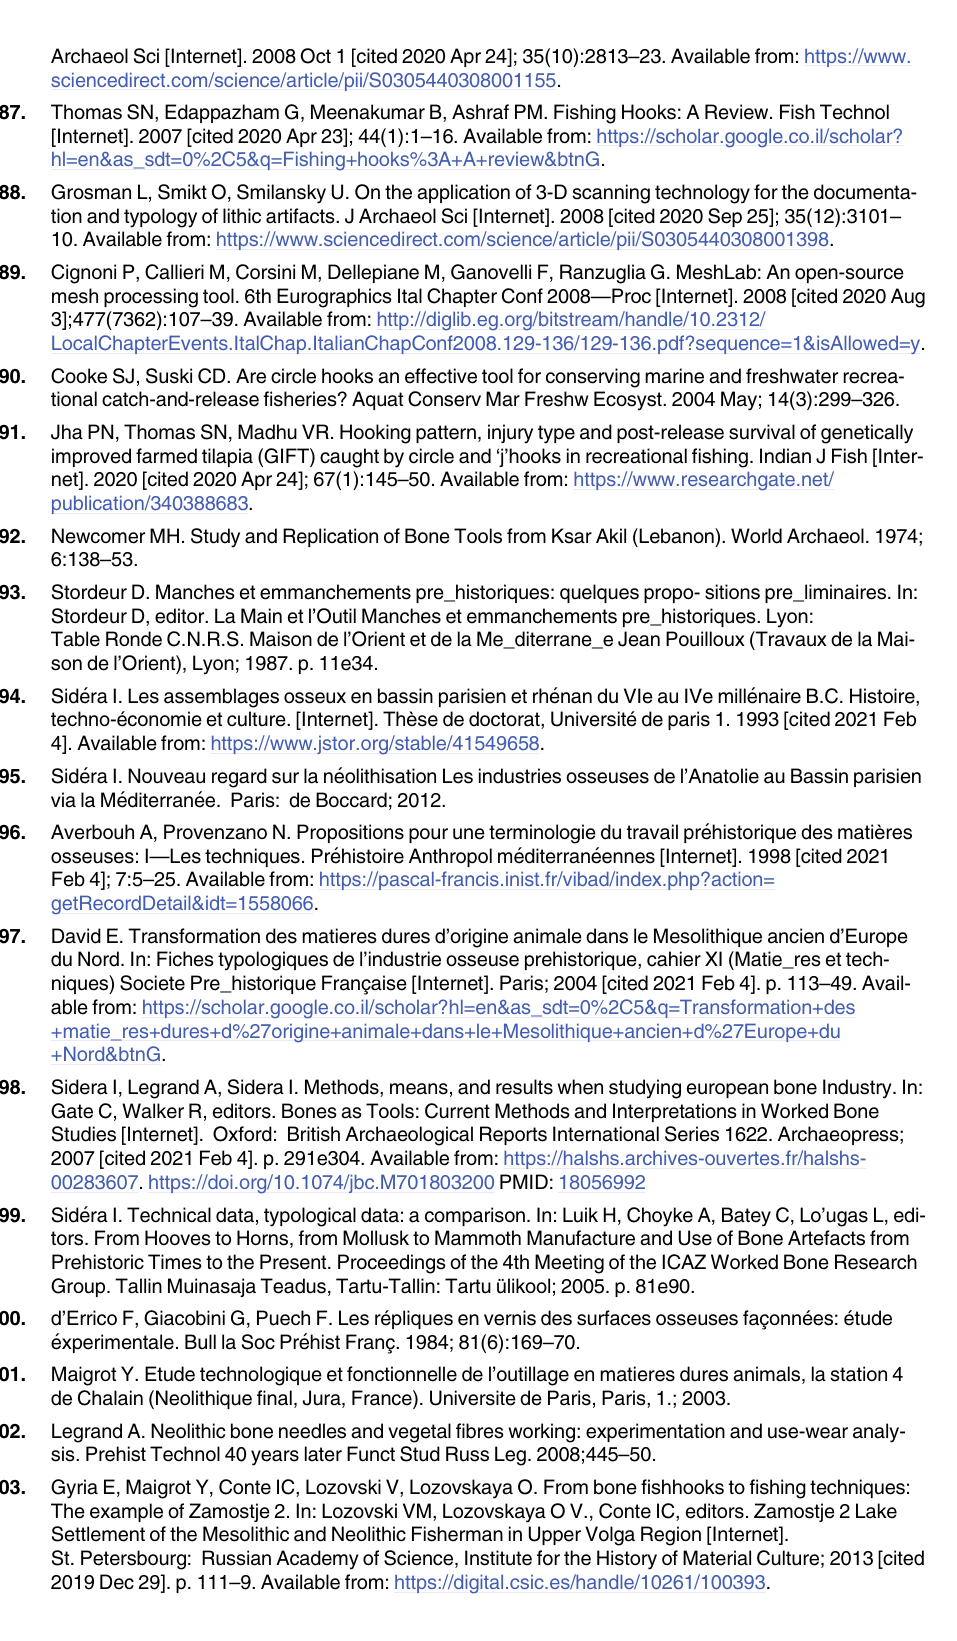
Table RondeC.N.R.S. Maison de l’Orient et de la Me_diterrane_e Jean Pouilloux(Travaux de la Mai- son de l’Orient), Lyon; 1987. p.